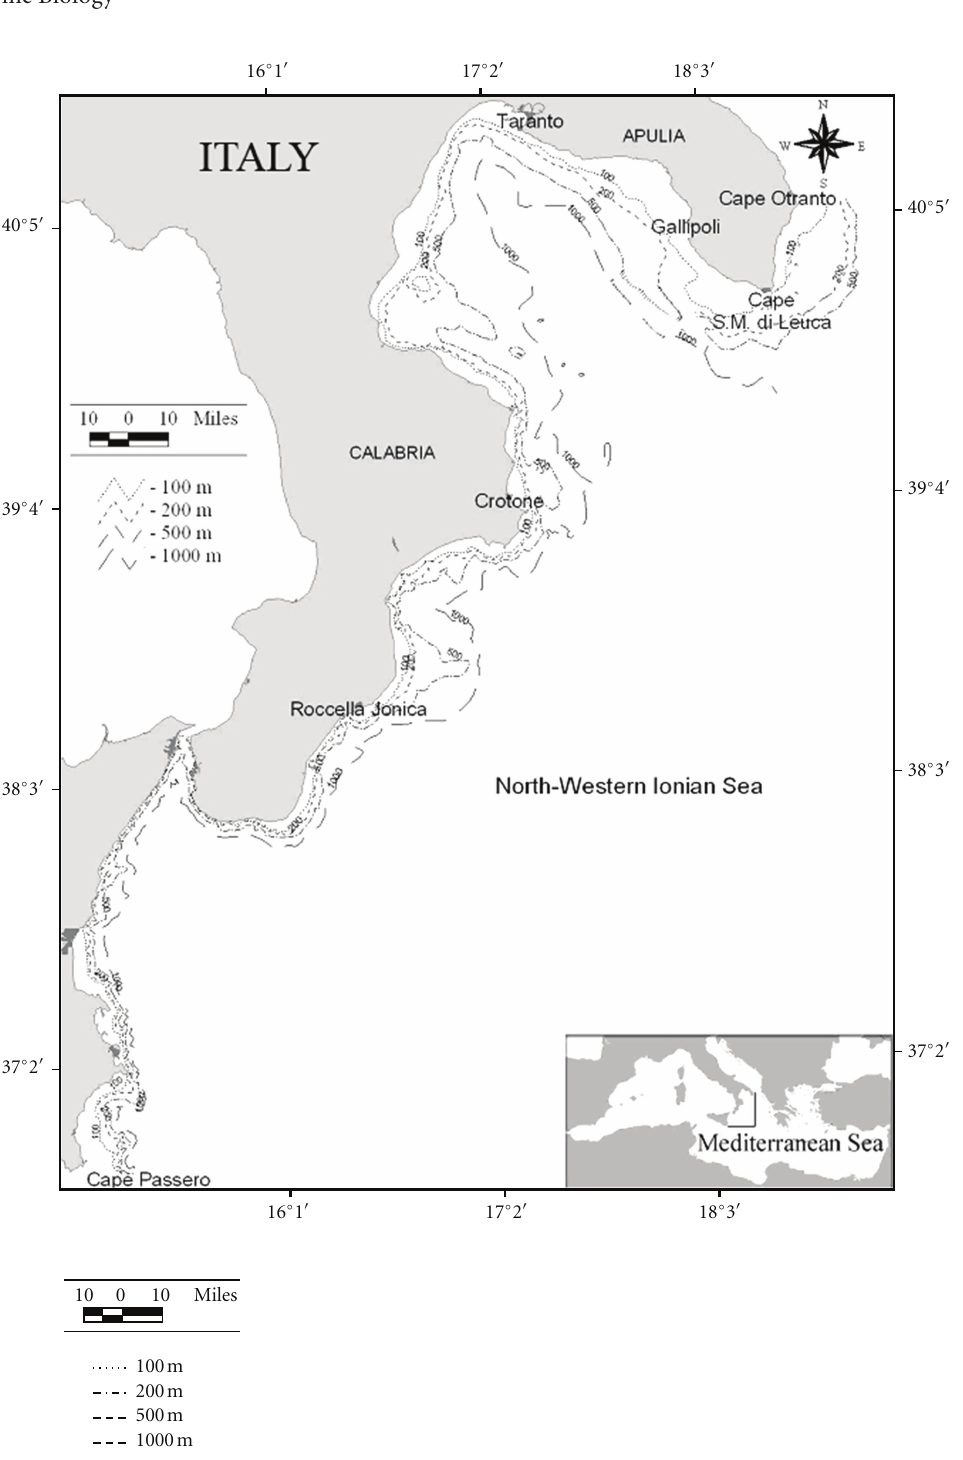
Figure 1: Map of the study